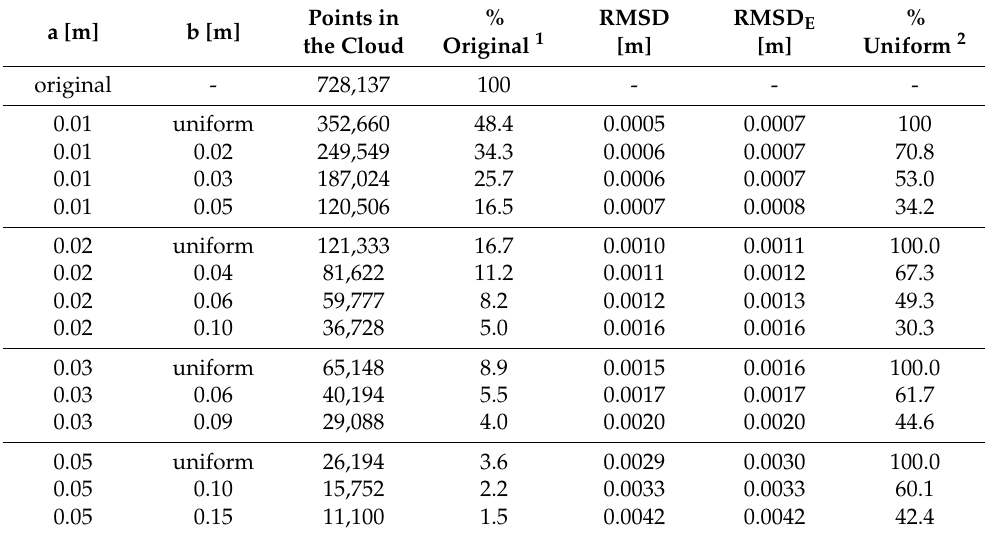
Table 2. Results of dilution of the Data 1 cloud—numbers of points and RMSDs (R = 0.05 m). Points a [m] b [m] a [m] b [m]